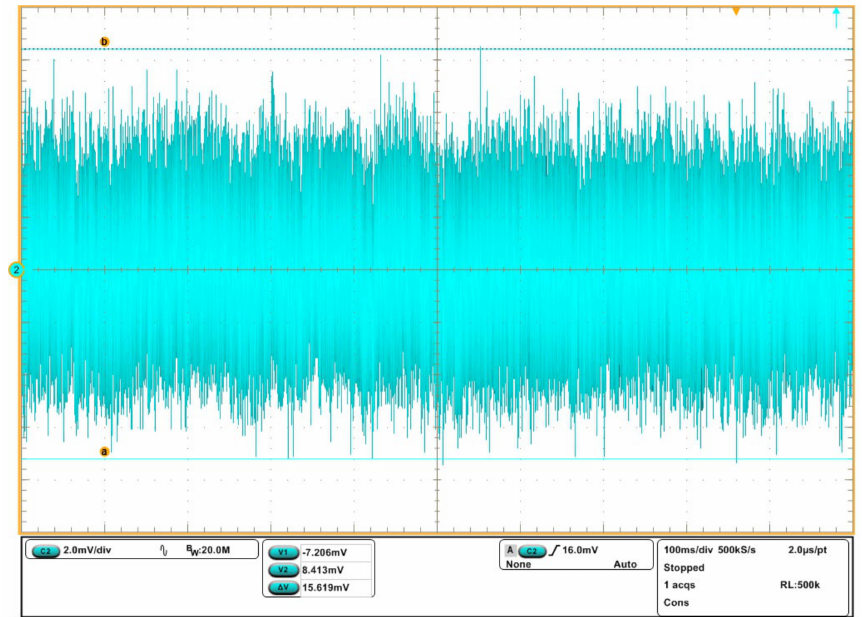
Figure 16. Measured ripple of the power amplifier using high-voltage operational amplifier.